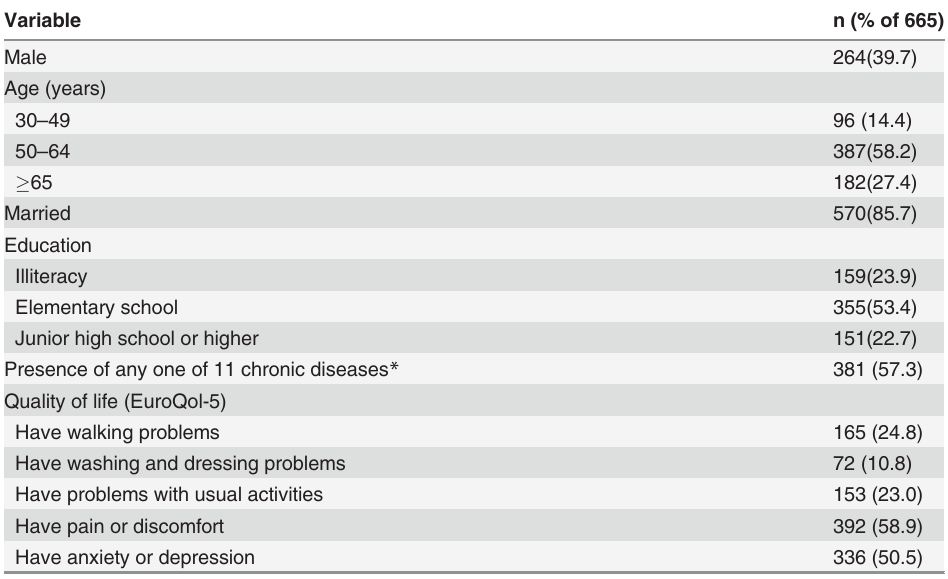
Table 1. Characteristics of patients with diagnosed